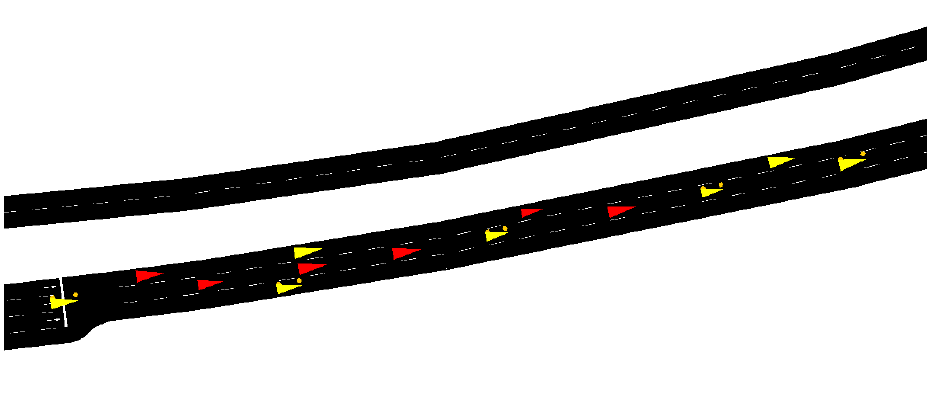
Figure 6. Highway traffic with platooning service use